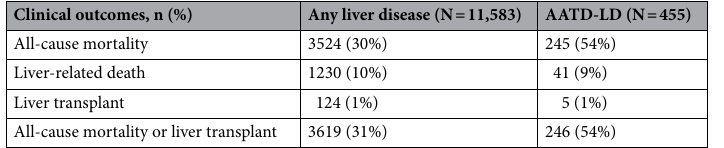
Clinical outcomes, n